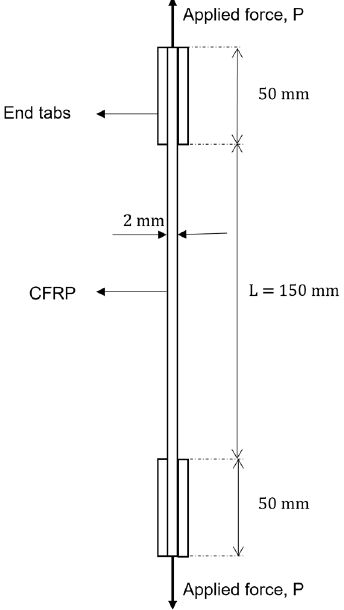
Figure 6. Tensile specimen schematic.